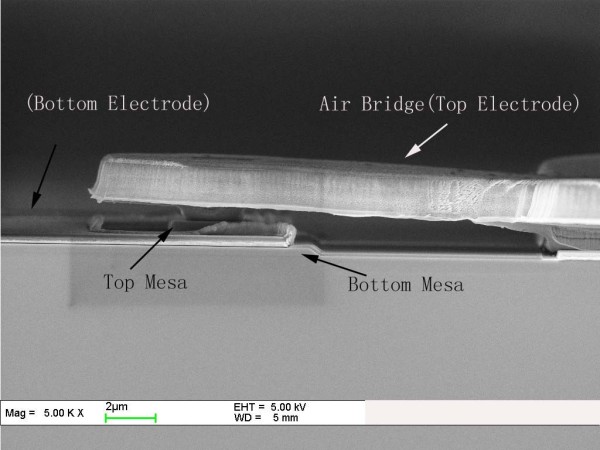
SEM photograph of a fabricated AlAs/In0.53Ga0.47As/InAs RTD-based InP substrate.